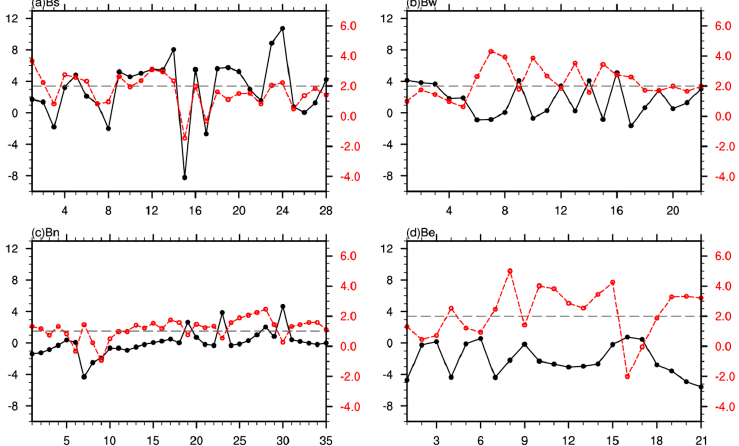
Figure 4. ( a ) Variations in the Bs (black line with dots) and its diurnal range (red line with dots) along the southern boundary of the TP. The abscissa represents the series numbers of sub-boundaries on the southern boundary in Figure 1. The horizontal gray dash line is the reference line of diurnal range of the Bs. ( b − d ) are the same as in ( a ), but for the western, northern, and eastern boundaries, respectively (unit: 10 6 kg s − 1 ).